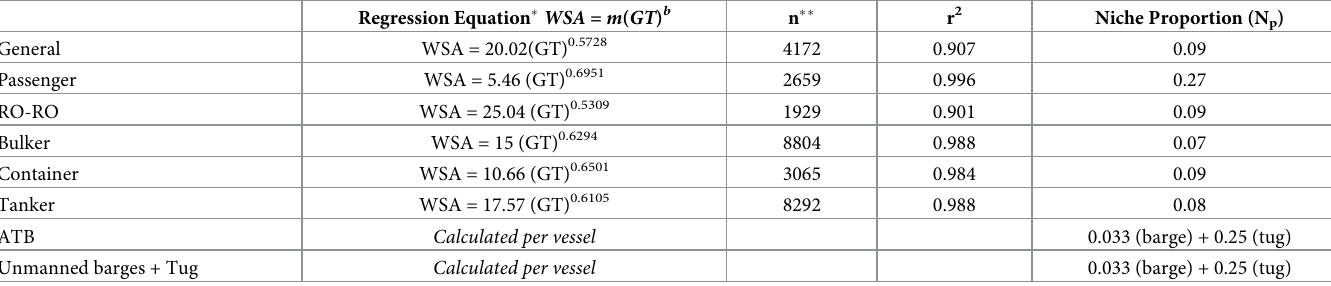
Table 1. Calculation of wetted surface